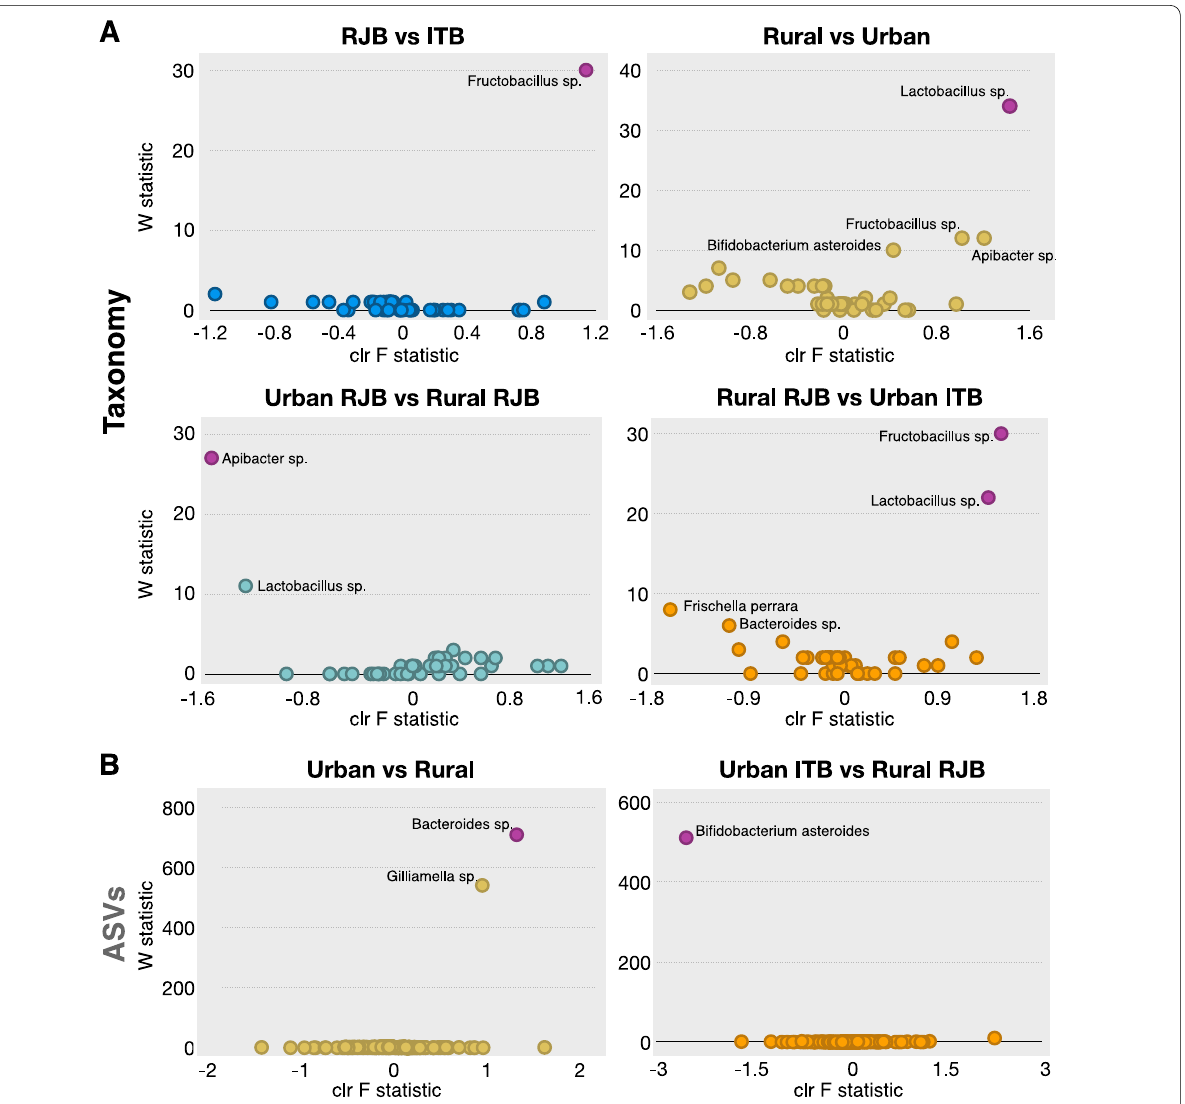
Fig. 4 ANCOM differential abundance volcano plots. The y-axis represents the W statistic value or the number of times of the null-hypothesis was rejected for a given A) taxonomic cluster or B) ASV. The x-axis value represents the centered log ratio (clr) transformed F statistic (the effect size difference for a particular taxon/ASV between groups). Taxa/ASVs with reject null-hypothesis are shown in pink and labeled with taxon name, all other taxa are colored the same within a given plot. Taxa/ASVs that were not significant but displayed a higher than average W value are